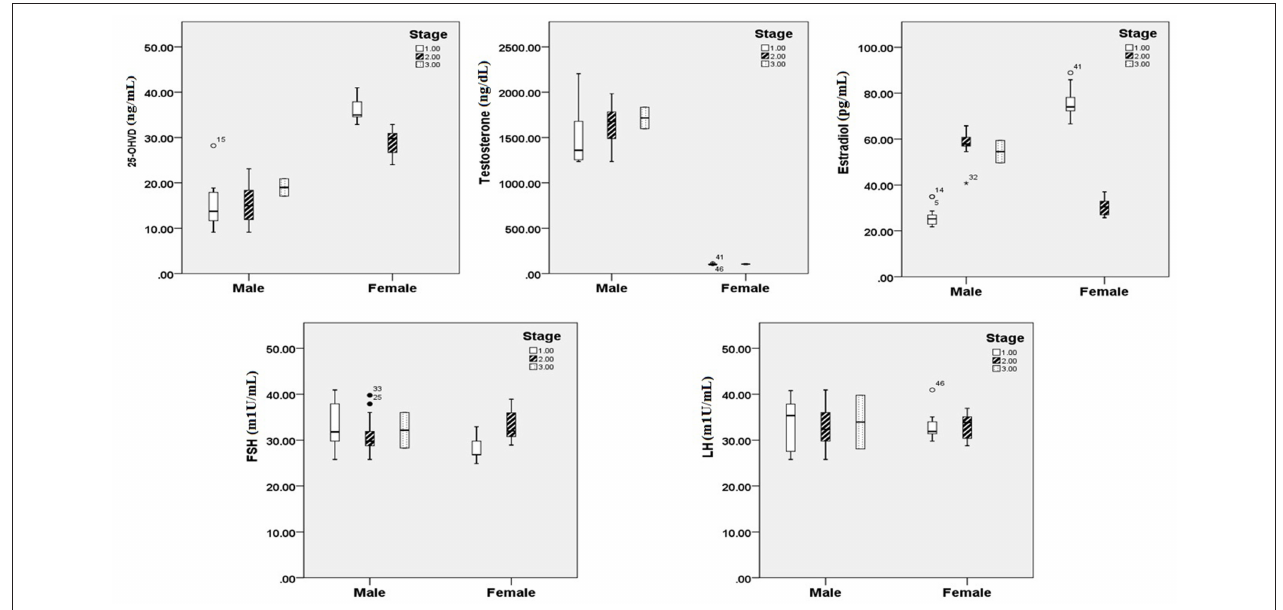
FIGURE 2 | 25-OH vitamin D and sex hormones patterns in relation to the stage of CRC in old participants ( n = 200). Pearson’s correlation at alpha = 0.05.